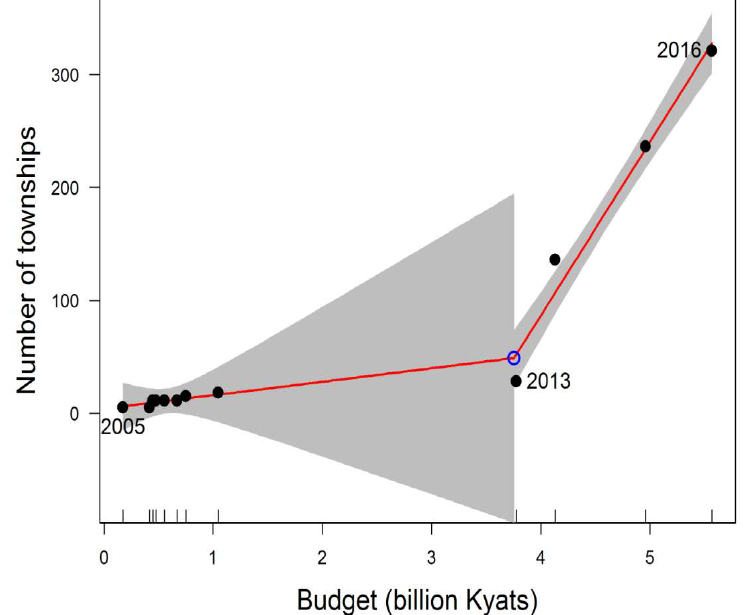
Figure 2. Relationship between government budget allocation for National TB Programme (NTP) and number of TB/HIV townships (2005–2016) using Joinpoint regression. Note: The grey shading represents 95% confidence interval of the estimated value.